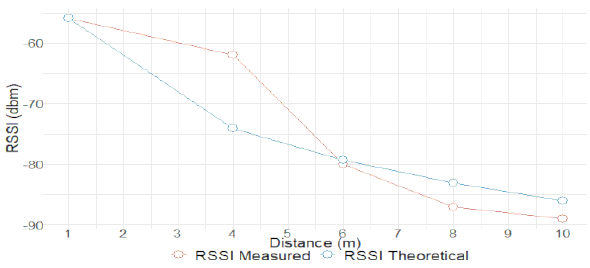
Figure 6. RSSI signal behavior in an obstacle